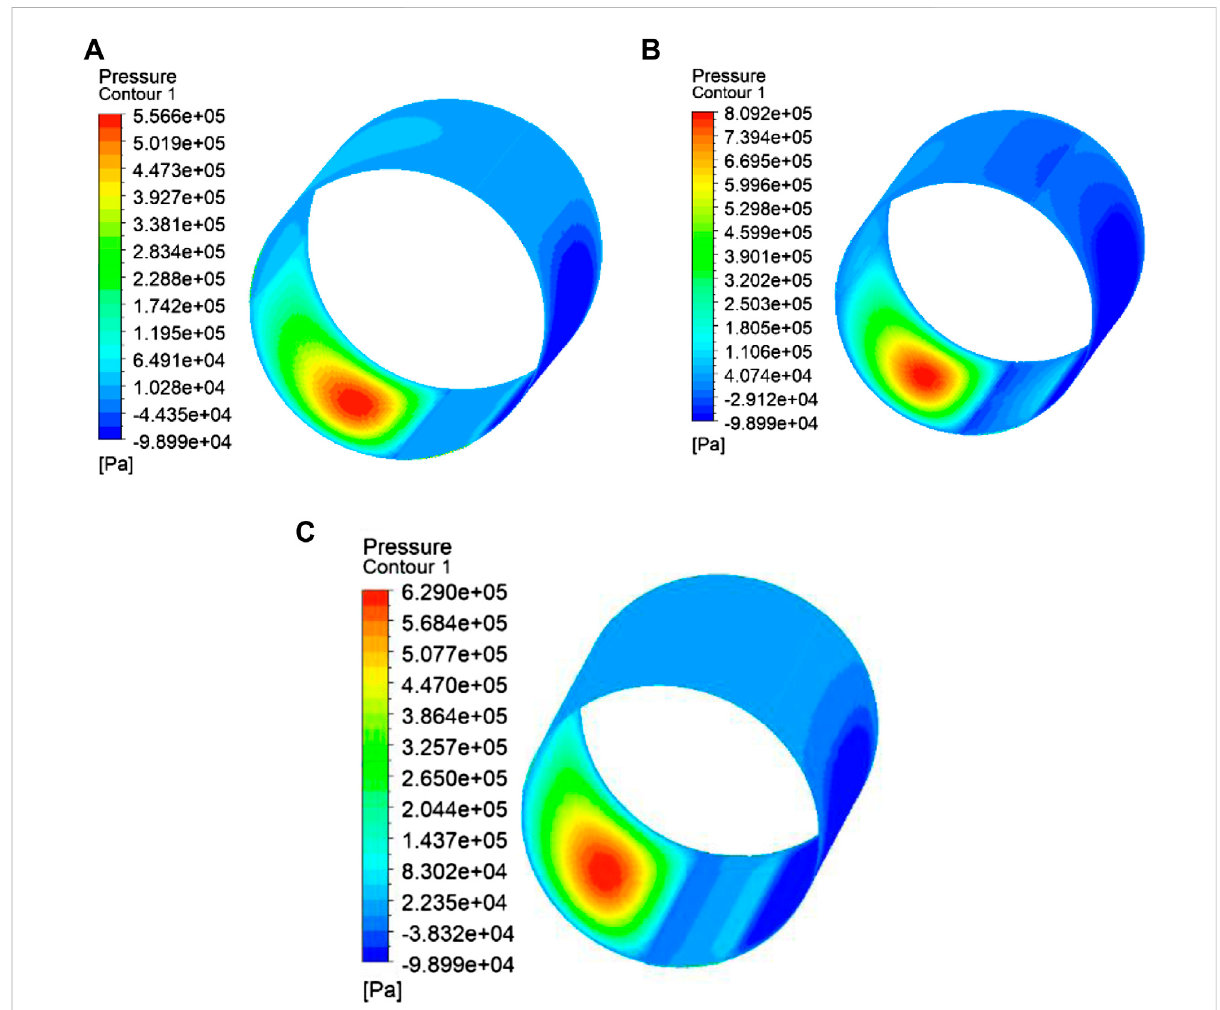
FIGURE 9 Pressure contour of the multistep journal bearing, ε = 0.7 dan ω = 3,000 rpm. (A) Laminar fl ow, (B) k-epsilon realizable, and (C) k-omega